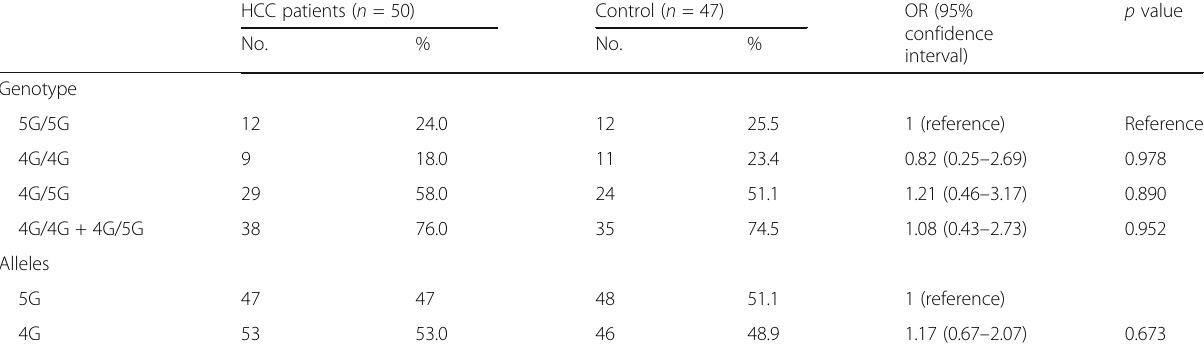
Table 3 The genotype distribution and the frequency of alleles of the PAI-1 4G/5G polymorphism in HCC and control groups